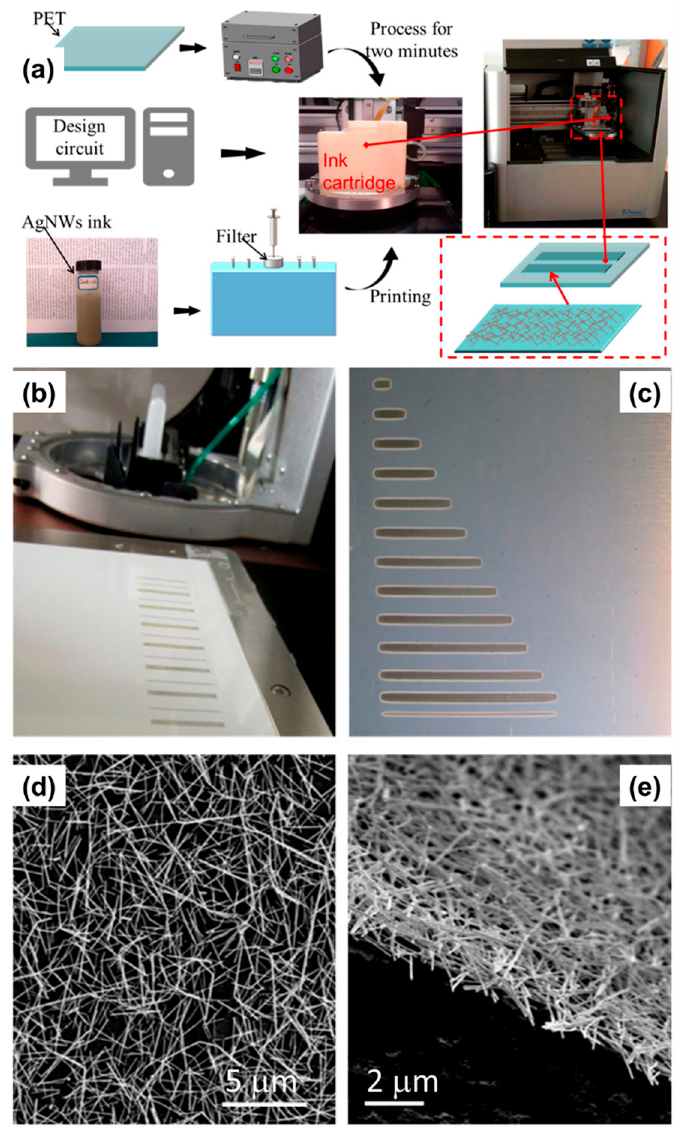
Figure 7. ( a ) Schematic diagram of the fabrication process of AgNWs-FTCE pattern by inkjet printing. Reproduced from Ref. [43] under the Creative Commons Attribution 4.0 International (CC BY 4.0) License). ( b – e ) Inkjet-printed Ag nanowire networks. ( b ) Inkjet printing of Ag nanowire lines on a coated PET substrate, which was aligned with index pins on the printer’s heated platen. ( c ) Printed lines of different lengths ( w = 2 mm, N = 20). ( d ) SEM image of a relatively thin Ag nanowire network ( N = 12 passes). ( e ) SEM images of the edges of thick nanowire networks ( N = 80 passes). Reproduced with permission from Ref. [46]. Copyright 2015, American Chemical